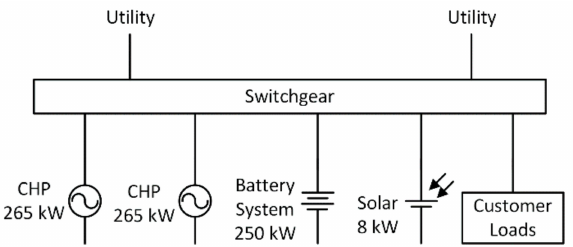
Figure 4. Example Microgrid #1—simplified single line